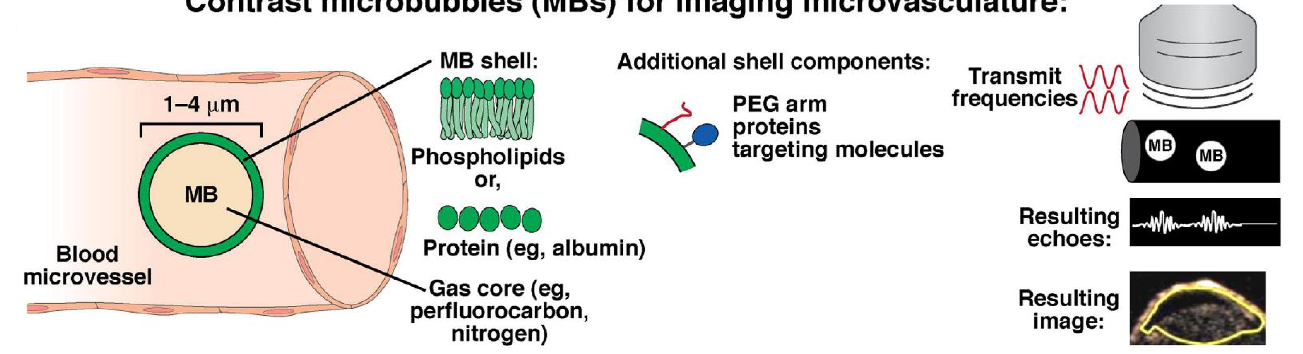
Figure 5. Principles of contrast-enhanced ultrasound imaging with contrast microbubble reported by Pysz et al. [147] Microbubbles generally consist of a gaseous core that is enveloped in a lipid or protein shell that may or may not be “decorated” with additional components for stability. Due to their micron size, microbubbles are able to travel within tiny microvascular spaces, including microcapillaries that may be present in solid lesions. Used with permission.